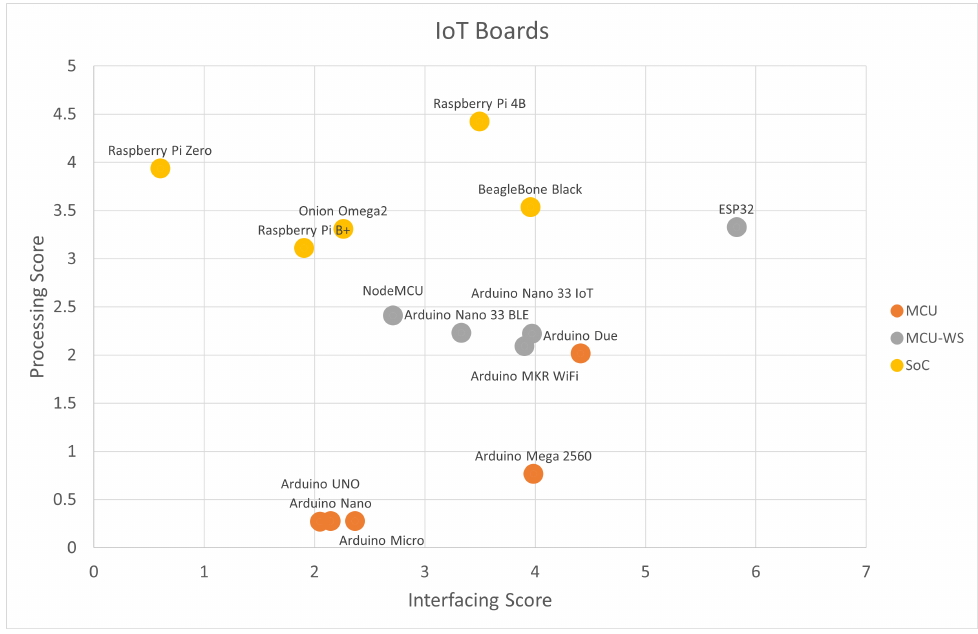
Figure 3. A classification of IoT